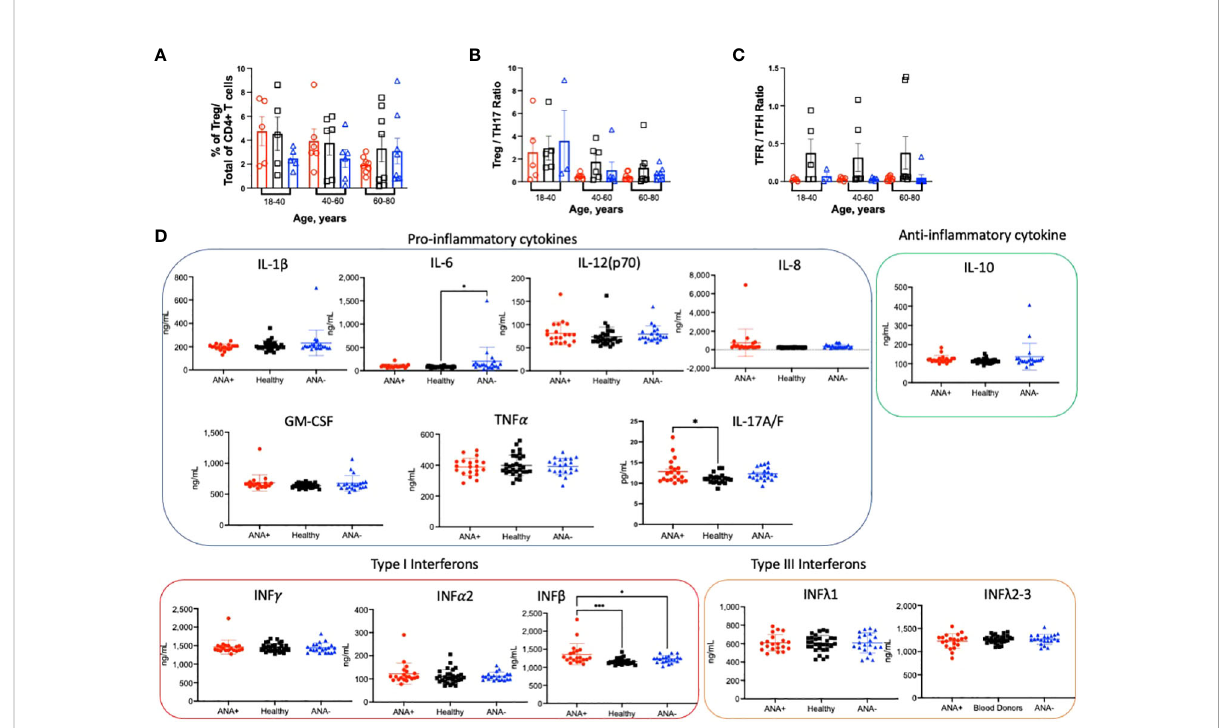
FIGURE 4 ANA-positivity does not correlate with changes in regulatory CD4+ T cells . PBMCs were isolated from whole blood collected from ANA-positive patients, ANA-negative patients, and healthy blood donors. Cells were stained with antibodies to identify (A) FoxP3+CD25+ regulatory T cells (Tregs). The ratios between (B) Tregs and TH17 and (C) T follicular regulatory (TFR) and TFH CD4+ T cells were calculated. (D) Plasma cytokines were measured by multiplex immunoassay. Each data point re fl ects one subject (ANA-positive = 20, ANA-negative = 20, healthy blood donors = 32). Data are shown as mean ± SEM and analyzed by a one-way ANOVA followed by Sidak ’ s multiple comparison test; *p<0.05,